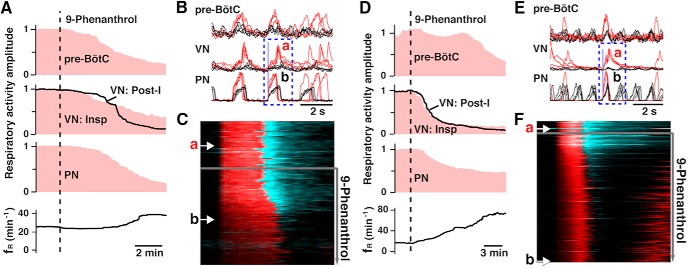
Time courses of perturbations of respiratory neural activities by TRPM4 channel inhibitor in mature rat and mouse arterially perfused in situ brainstem–spinal cord preparations. A–C, Time courses of integrated burst amplitudes (normalized to mean control amplitudes, pink mountain plots) of inspiratory pre-BötC neural population activity (pre-BötC) obtained by extracellular recordings, vagus nerve (VN) inspiratory (Insp) and postinspiratory (post-I) activity (solid black line in middle panel in A), phrenic nerve (PN) inspiratory activity, and respiratory frequency (fR) in perfused preparation from mature (4-wk-old) rat. TRPM4 inhibitor 9-phenanthrol (50 µm) was added to the perfusate at the vertical dashed line. B, Cycle-triggered overplots of the three neurograms (pre-BötC, VN, and PN) digitally triggered at the onset of PN activity (vertical solid line) before (red, corresponding to time points marked by arrow a in C) and after the inhibitor (black traces, at arrow b in C). C, Dynamic raster plots of cycle-triggered PN inspiratory (red) and VN including post-I (cyan, right side) activities. After 9-phenanthrol, TI (red) was prolonged, PN and VN inspiratory amplitude declined (darkened red), and fR increased (see A) as post-I activity amplitude declined. D–F, Same type of data sets and analysis for an adult (4-mo-old) mouse preparation showing perturbations of pre-BötC, VN, and PN activity, including loss of VN post-I activity and associated increase of fR, following administration of 9-phenanthrol (20 µm).